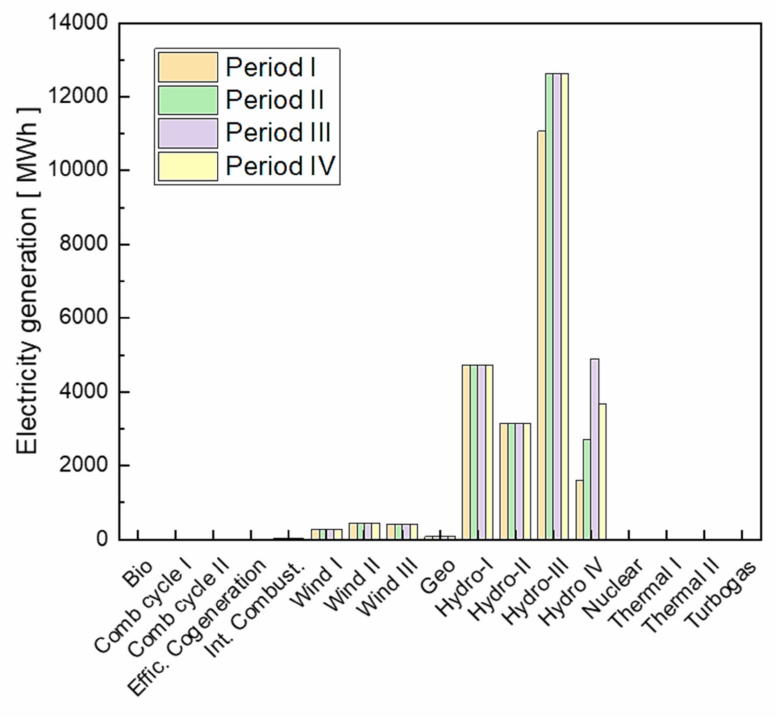
Figure 7. Contribution of energy generation by each plant of the study in the periods.